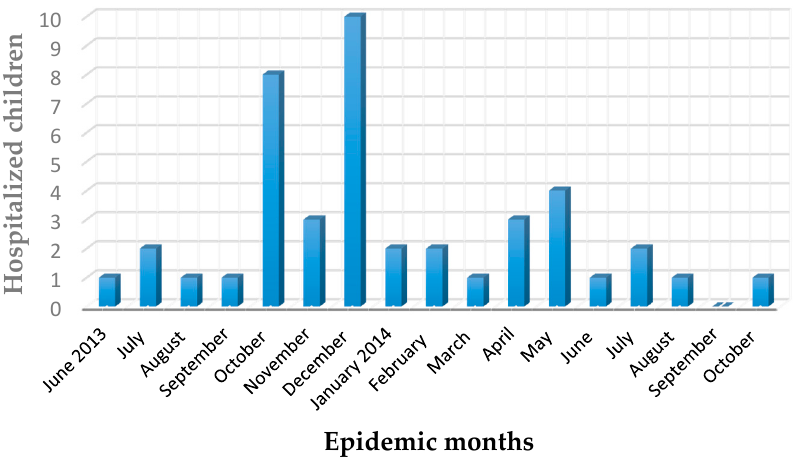
Figure 2. Distribution by months of 44 children with Salmonella enterica Typhimurium infection.